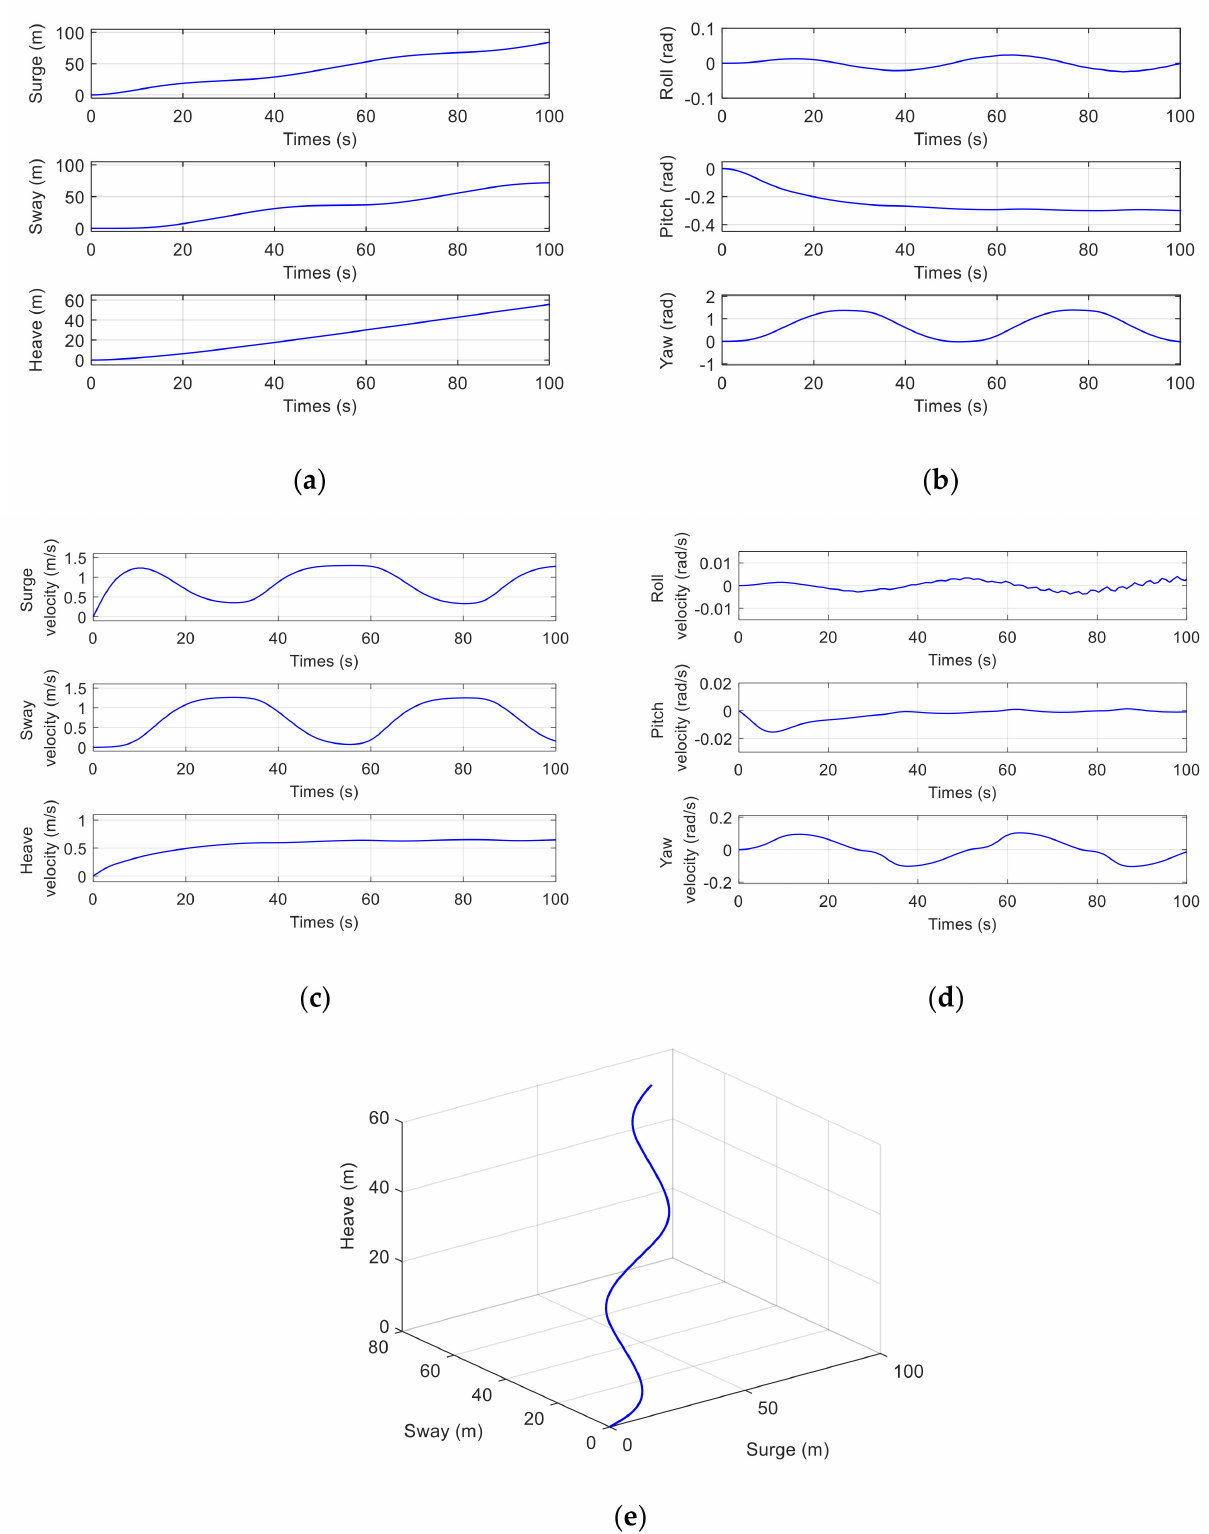
Figure 6. Yaw motion of the MJ-AUV: ( a ) Position changes over time; ( b ) Attitude changes over time; ( c ) Linear velocity changes over time; ( d ) Angular velocity changes over time; ( e ) 3D